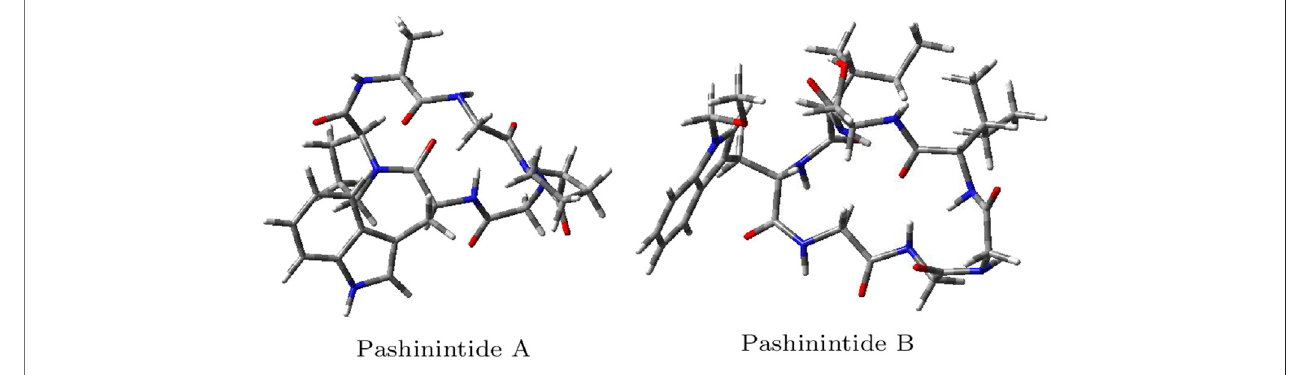
FIGURE 4 | Optimized molecular structures of the Pashinintides A and B.